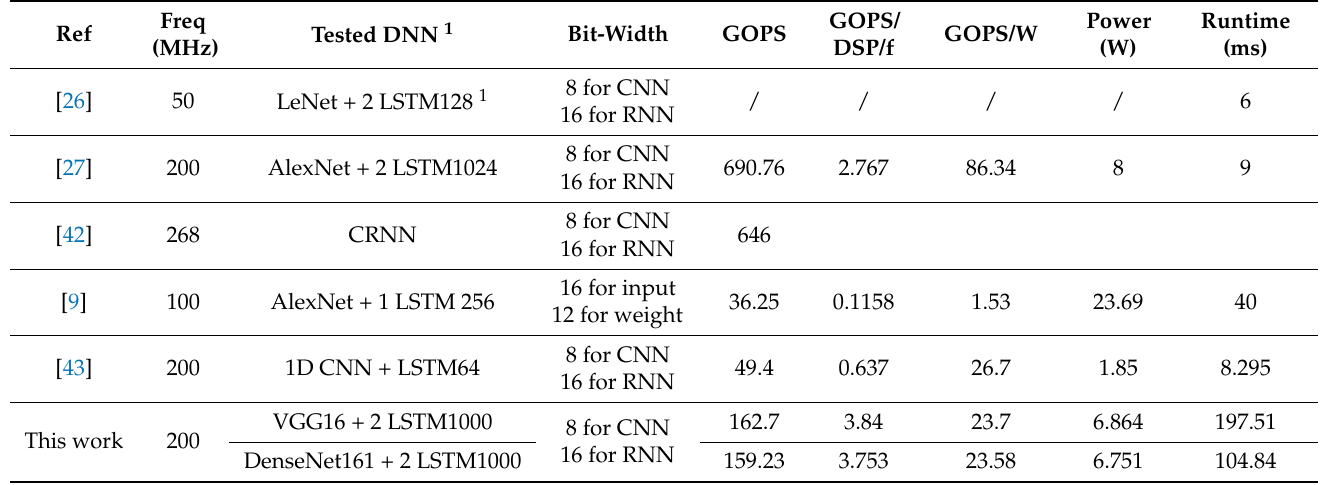
Table 5. The experiment results for the hybrid DNNs on the proposed VPU and the comparison with the previous